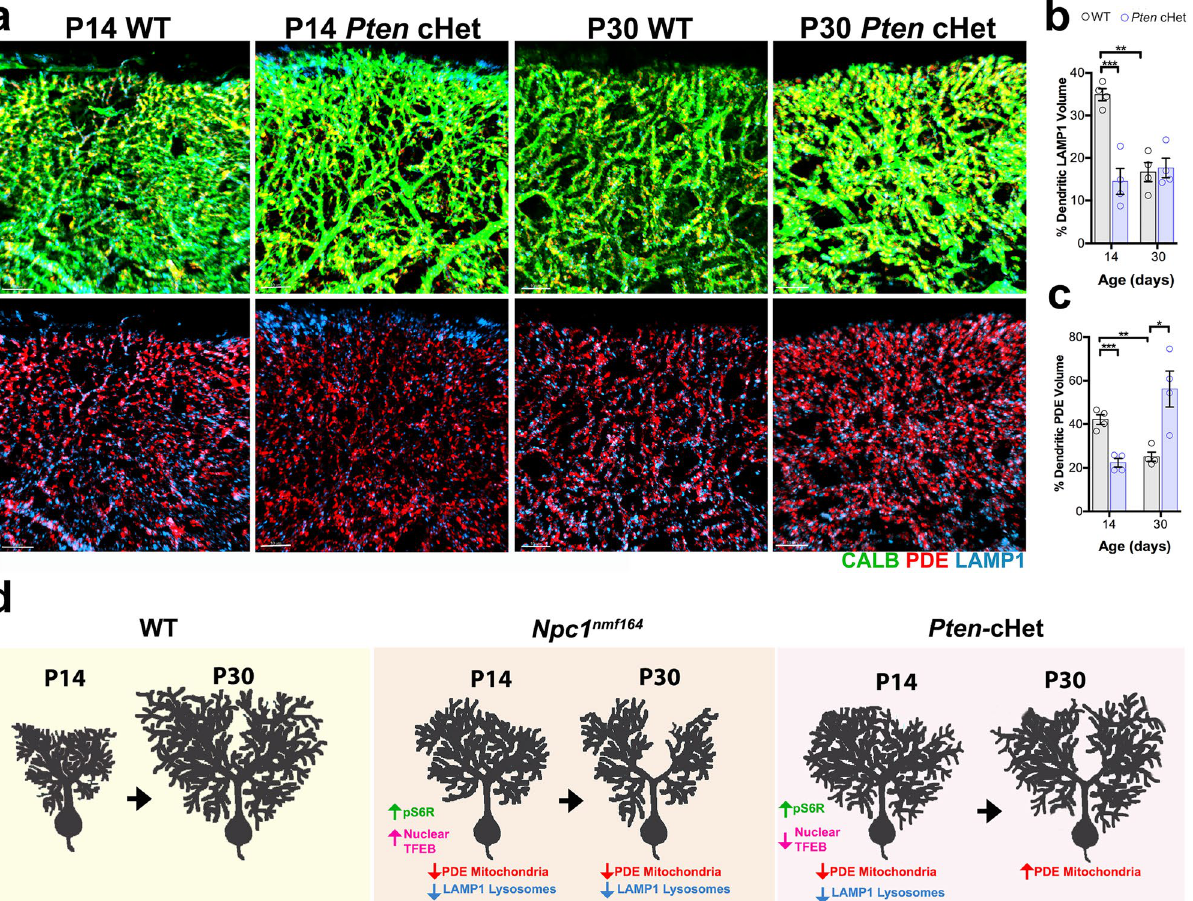
Figure 8. Pten conditional haploinsufficiency in PCs alters mitochondrial and lysosomal levels in PC dendrites during postnatal development. ( a ) Segregated PDE (mitochondria) and LAMP1 (lysosomes) immunoreactivity in CALB + PC dendrites in WT and Pten- cHet mice at P14 and P30. ( b ) Measurement of the percentage of LAMP1 volume in PCs dendrites at P14 and P30 showing significant differences between WT and Pten- cHet mice. ( c ) Measurement of the percentage of PDE volume in PCs dendrites at P14 and P30 showing significant differences between WT and Pten- cHet mice. Data are presented as mean ± SEM, n = 4 mice/genotype/age. **P < 0.001, ***P < 0.001. Scale bars: ( a ) 5 μm. ( d ) Schematic illustration showing how changes in activation of the mTORC1 pathway (pS6R) and TFEB occur along with significant changes in the size of the dendritic tree of PCs from Npc1 nmf164 and Pten- cHet mice during postnatal development. Changes in dendritic mitochondrial and lysosomal volume were evident in the different mouse strains, suggesting that lysosomal dysfunction in NPC1 deficient mice disturbs metabolic balance and causes dendritic